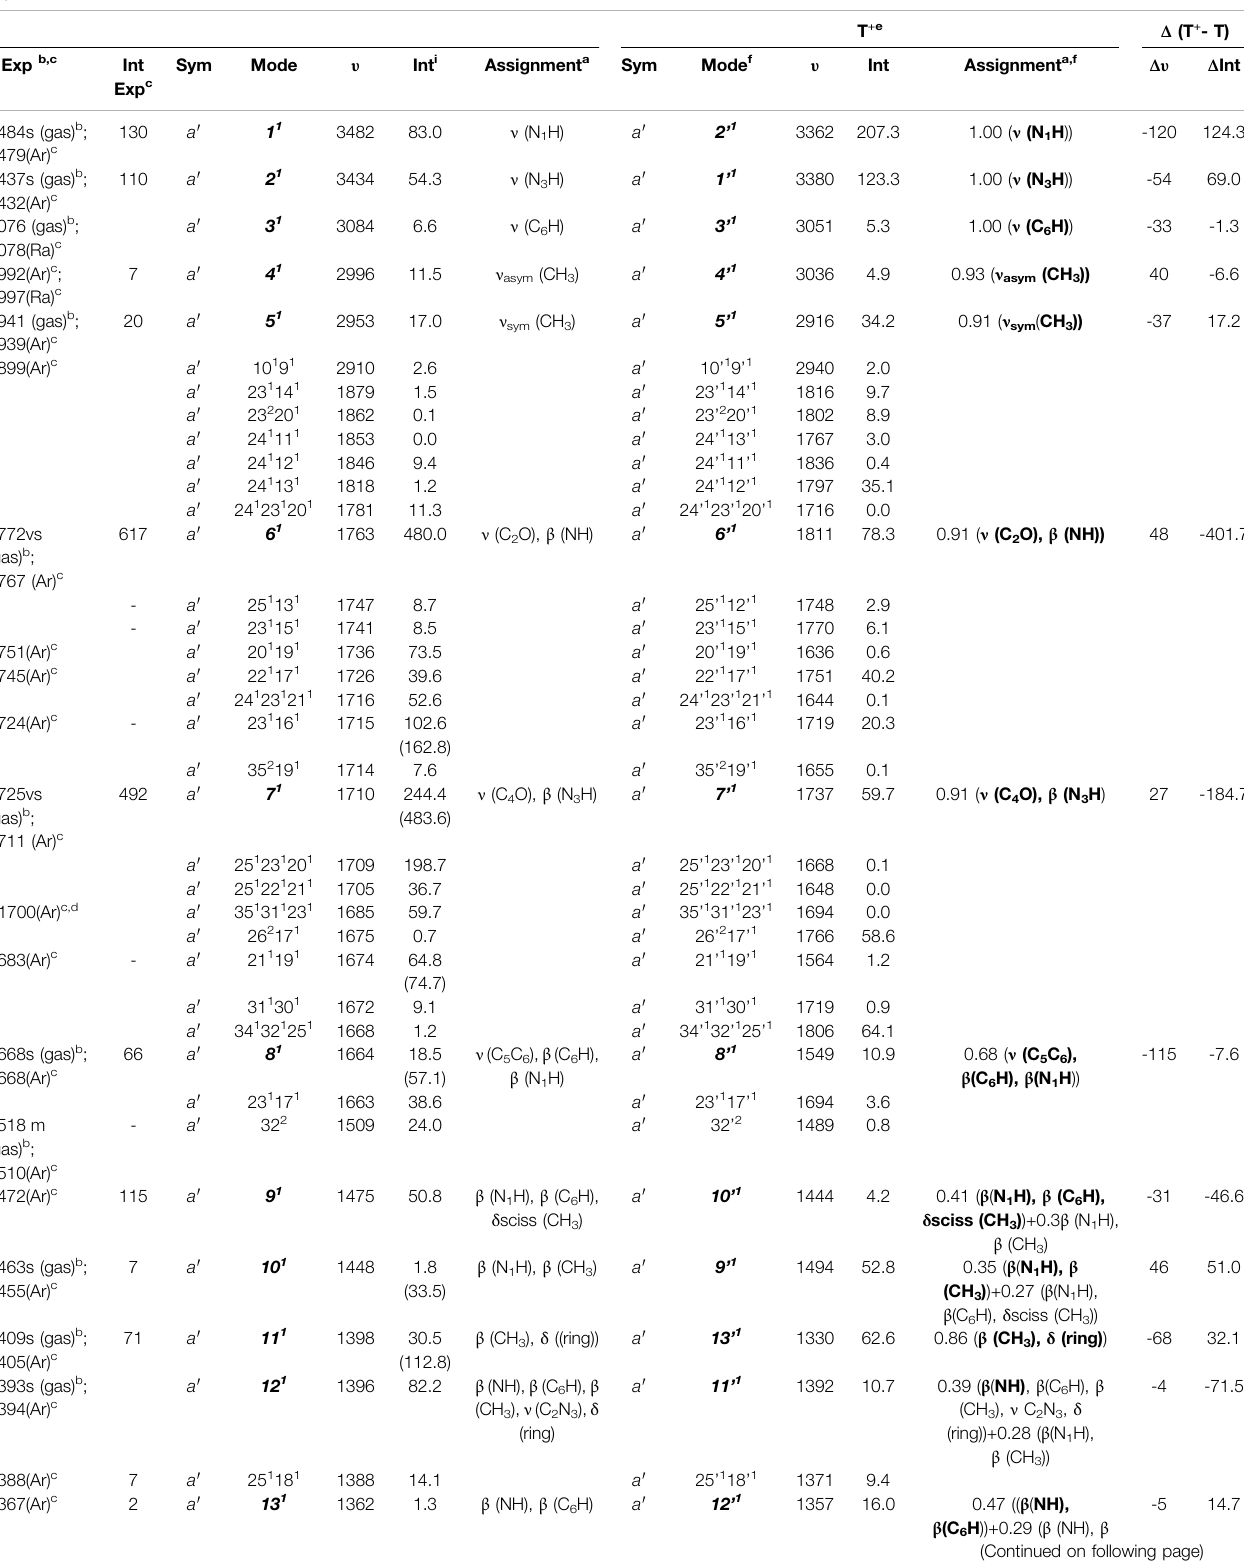
TABLE 2 | Anharmonic wavenumbers ( υ , cm − 1 ) and IR intensities (km/mol) computed at GVPT2//B2PLYP//B3LYP/AVTZ level for T (X (cid:1) 1 A ′ ) and T + (X (cid:1) 2 A ″ ) compared with experimental